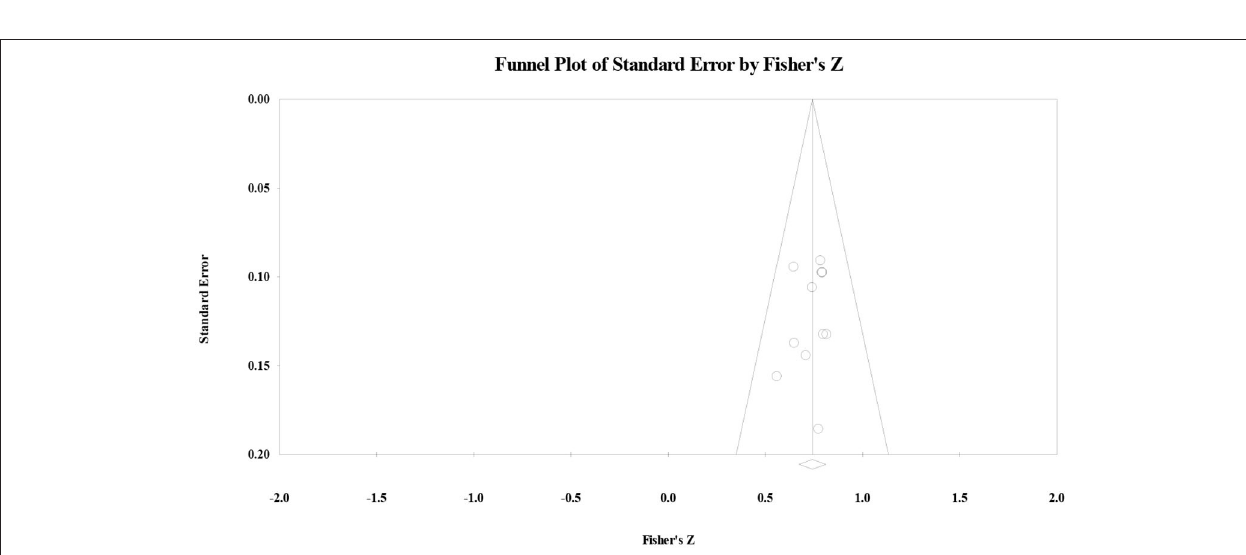
FIGURE 2 | Funnel plot of the correlation effect size between vocabulary knowledge and reading comprehension for primary school students.